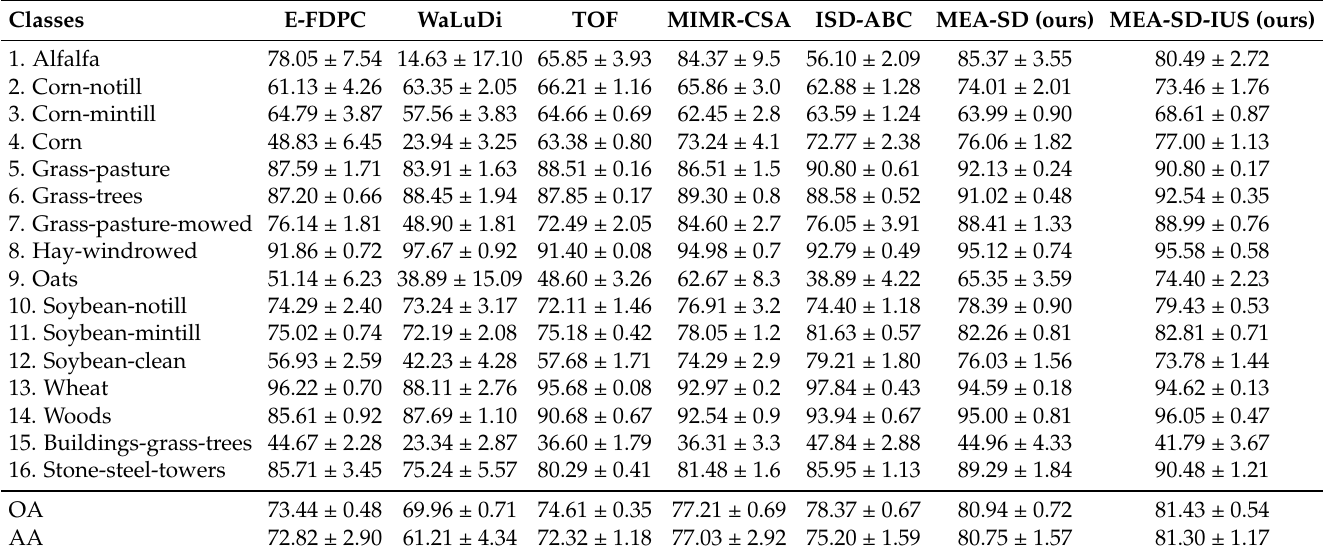
Table 5. The detailed classification accuracies (%) of different methods on Indian Pines dataset.